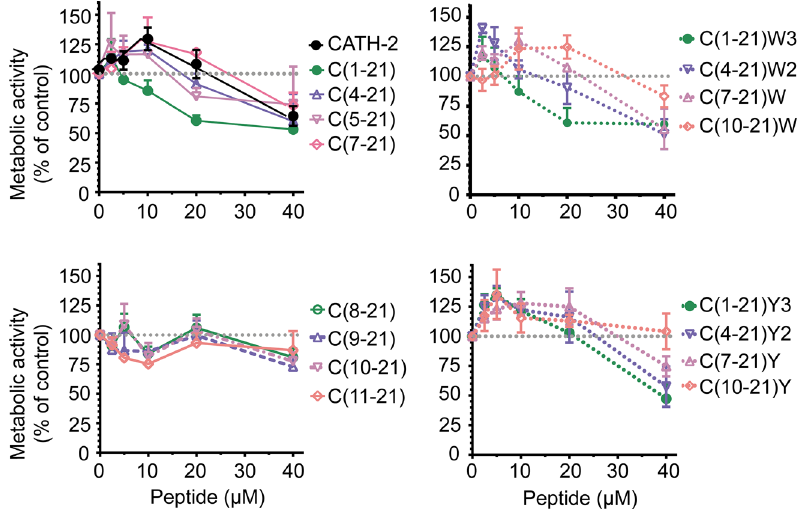
Fig 1. Metabolic activity of CATH-2 derived peptide treated HD11 cells. Metabolic activity of HD11 determined by WST-1 assays after 24 h stimulation with CATH-2 derived peptides (2.5 – 20 μ M). Shown are means ± SEM for at least 3 independent